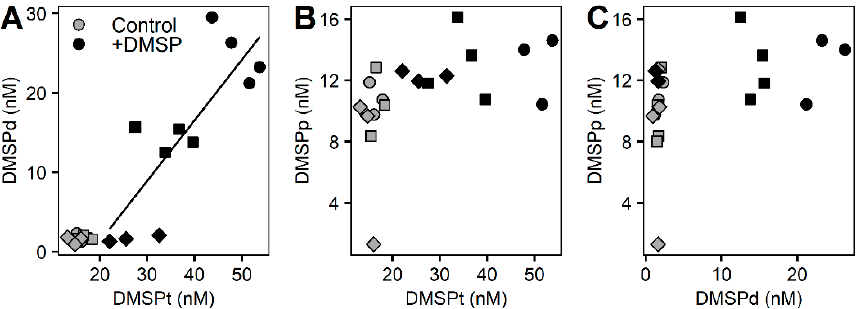
Figure 3. Correlations between the different DMSP concentrations. Control samples (light grey) and enriched DMSP samples (black) for time 0 h (circles), 3 h (squares), and 6 h (diamonds) are represented for DMSPd vs. DMSPt ( A ), DMSPp vs. DMSPt ( B ), and DMSPp vs. DMSPd ( C ). Significant correlation: ( A ) r 2 = 0.668, p = 0.002.